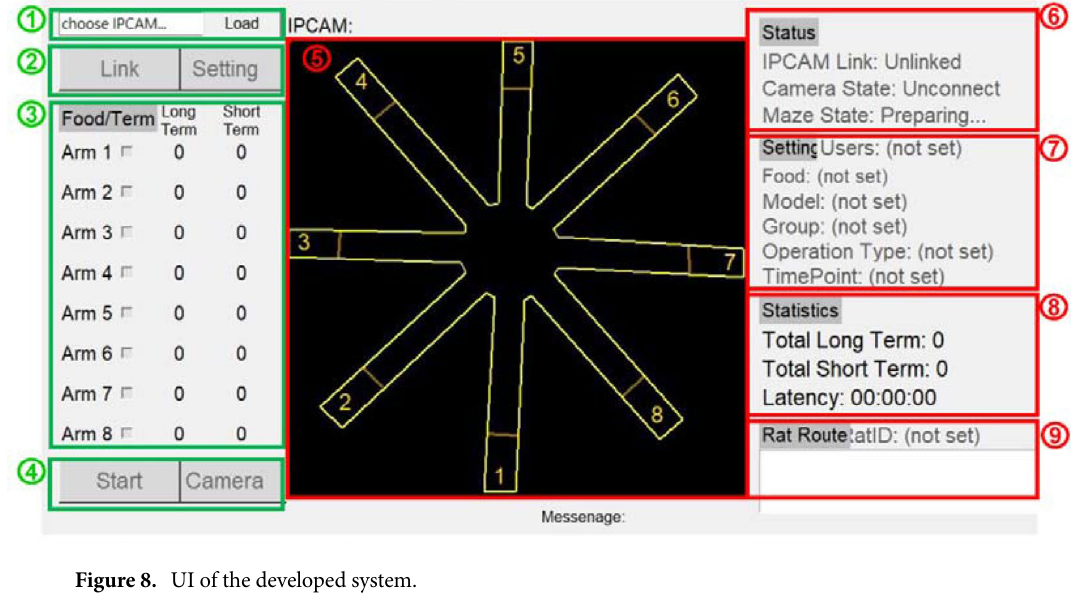
Figure 8. UI of the developed system.